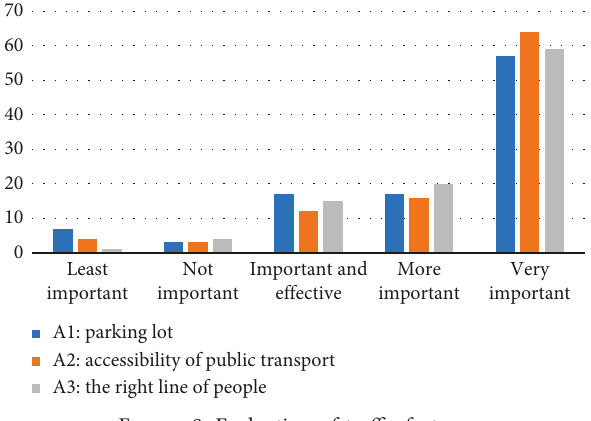
Figure 9: Evaluation of traffic